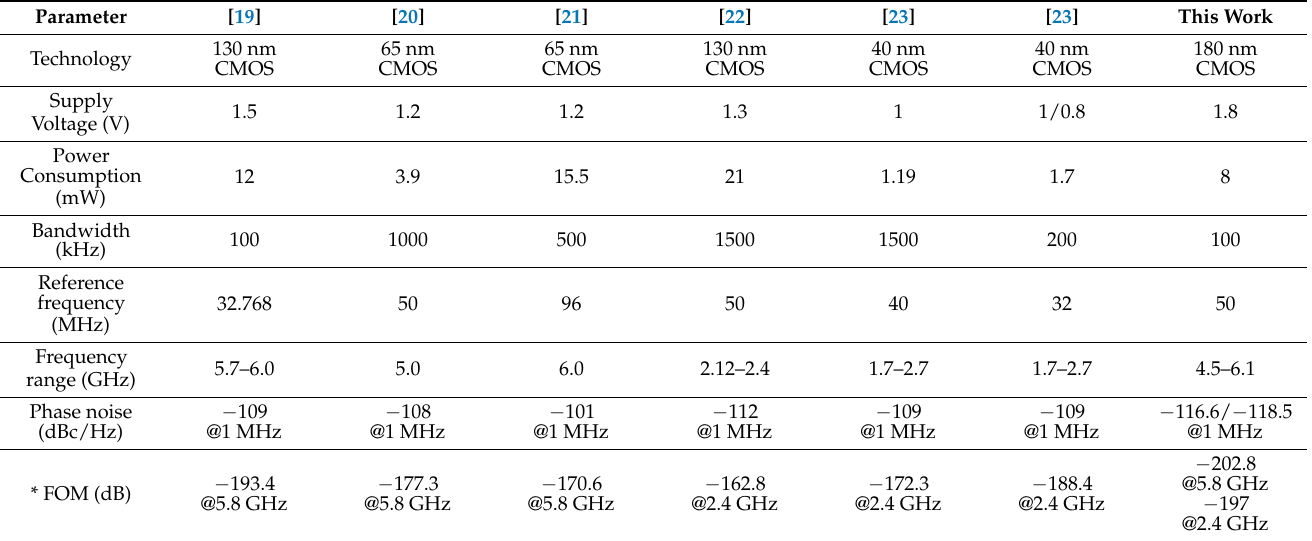
Table 1. Performance Comparison with Prior